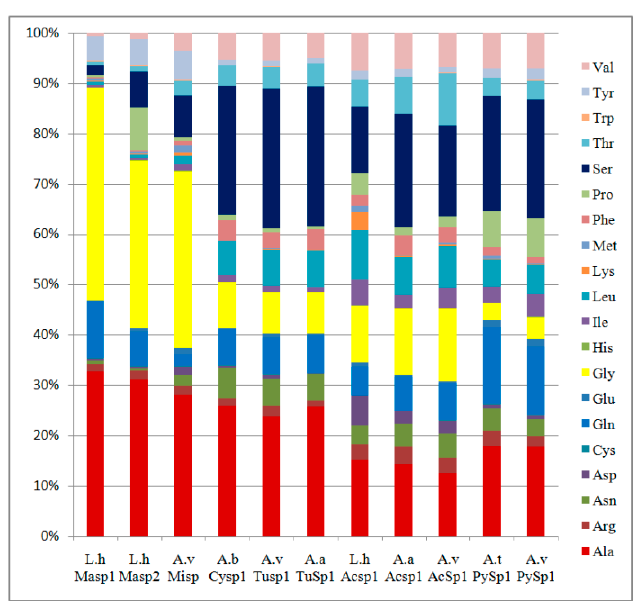
Figure 7. Amino acid compositions of complete L.h MaSp1, L.h MaSp2, A.vMiSp, A.b CySp1, A.v TuSp1, A.a TuSp1, L.h AcSp1, A.a AcSp1, A.v AcSp1, A.t PySp1, A.v PySp1.